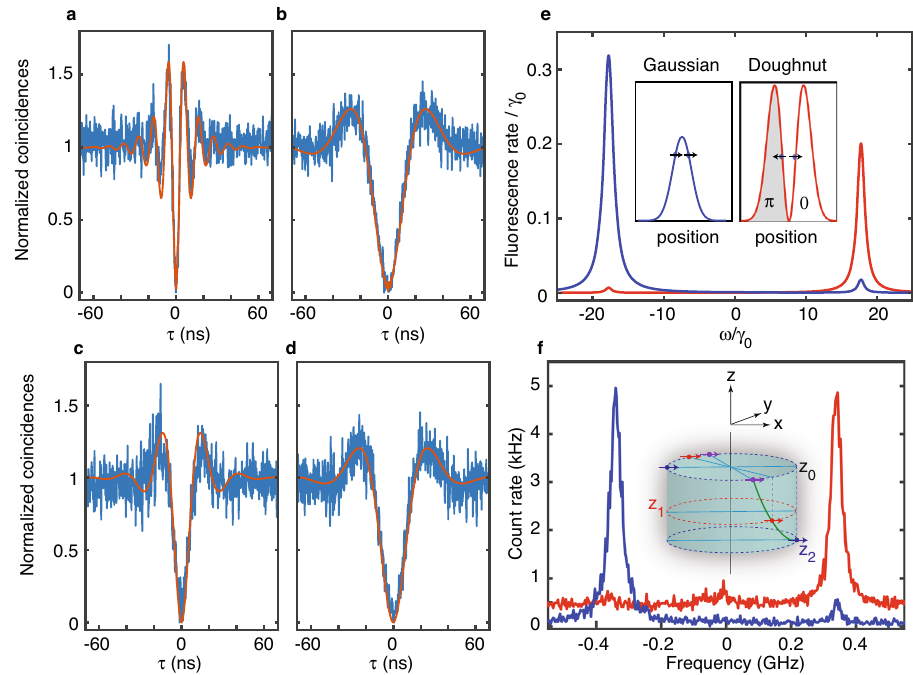
Fig. 4 Selective excitation of superradiant and subradiant states. a , b Normalized photon coincidence histograms (after background subtraction) measured for a pair of coupled molecules excited with a Gaussian-shaped laser beam of intensity 200 W cm − 2 at resonance with the | G 〉 → | S 〉 transition ( a ) and with the | G 〉 → | A 〉 transition ( b ) when the degree of superposition is maximized by Stark effect ( P E ∼ 0.92, voltage 150 V). They are characterized by an antibunching dip and damped Rabi oscillations, while photon bunching is evidenced when the laser is resonant on the two-photon transition (Supplementary Fig. 10). The second-order correlation functions (red curves) are computed for nearly parallel dipoles in the J-con fi guration with V = − 17 γ γ = 0.3 γ Δ = 10 γ 0 , 12 0 , and 0 (See Methods). c , d Photon coincidence histograms obtained for the same pair of coupled molecules when the molecular resonances are tuned apart by Stark effect ( − 150 V), leading to a modest degree of superposition P E ∼ 0.24. The excitation intensity is 40 W cm − 2 . The simulations are performed with the same parameters except for Δ = 60 γ 0 . e , f Simulated ( e ) and experimental ( f ) spectra of the same pair excited with a Gaussian-shaped beam of 8 nW (blue curves) and a doughnut-shaped beam of 1 µ W (red curves) centered midway between the molecules. The associated pro fi les of the laser fi eld amplitude and phase are schematically displayed in the inset of ( e ). The simulations are performed with the above values of V , γ 12 , Δ , and with a = 0.8, b = 0.6. Depending on whether the emitters are excited in phase (Gaussian beam) or out of phase (doughnut beam), exclusive pumping of the superradiant or the superradiant state, respectively, is performed. The inset of ( f ) exempli fi es three parallel-dipole con fi gurations represented by blue, red, and purple couples of arrows, leading to the same coupling strength V and spectra (Supplementary Fig. 11). The positions of the dipoles may differ along the optical (z) axis, while their projections in the focal ( x , y ) plane are separated by 18